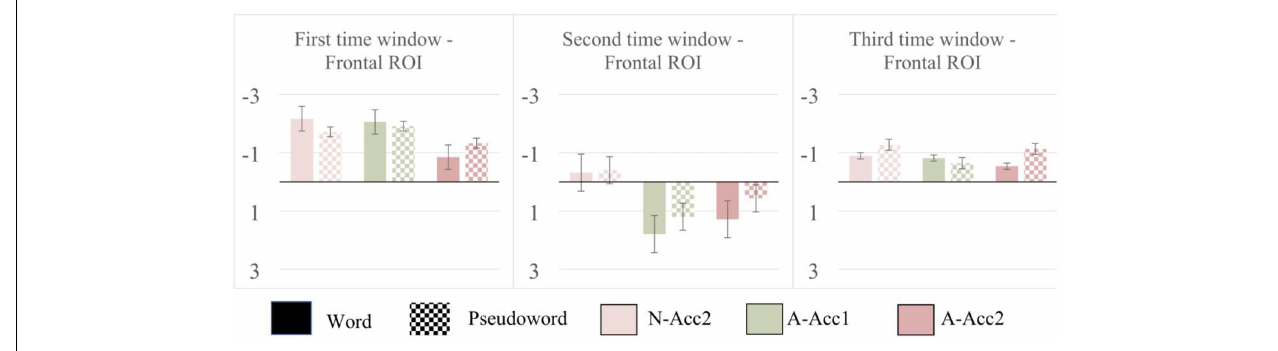
FIGURE 3 | Illustration of the mean and the standard error of the mean for deviant-minus-standard amplitudes (color-coded in accordance with Figures 1 , 2 ) extracted from the frontal electrodes (F3, Fz, F4). Black bars: Word block; Checked bars: Pseudoword